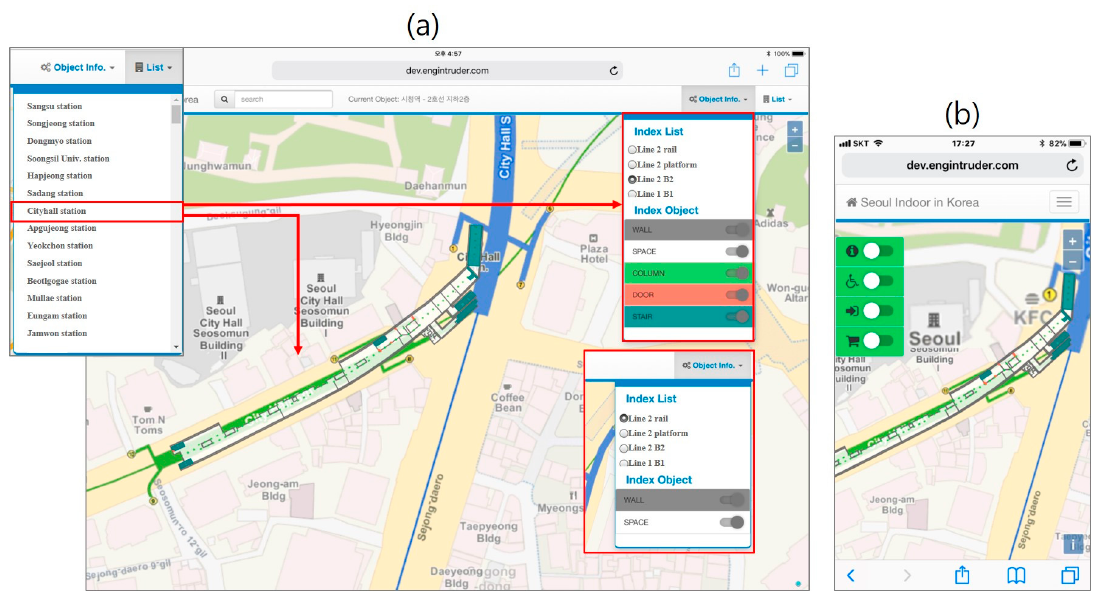
Figure 10. Results of the 2D building visualization, object selection, and indoor POI radio button for ( a ) iPad mini and ( b ) iPhone.